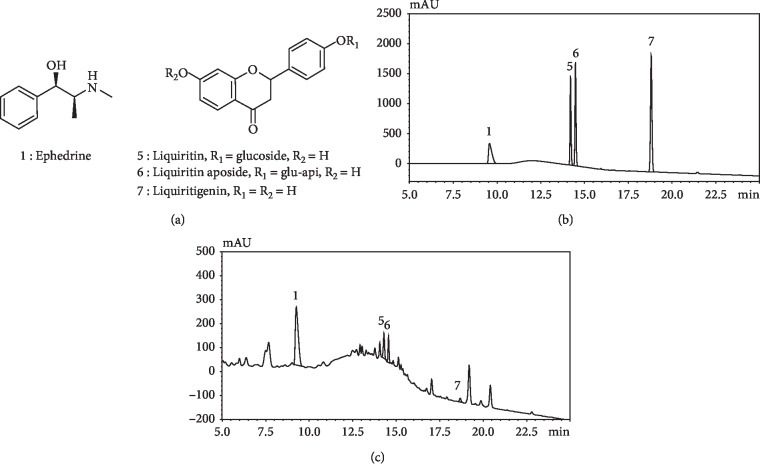
The HPLC analysis data of MHT extract: (a) The structures of four compounds. (b) The HPLC chromatograms of the standard mixture 0.2 mg/mL, λ = 207, of ephedrine (1) at 9.65 min, liquiritin (5) at 14.20 min, liquiritin apioside (6) at 14.49 min, and liquiritigenin (7) at 18.81 min. (c) The extracted MHT sample (0.5 mg/mL).